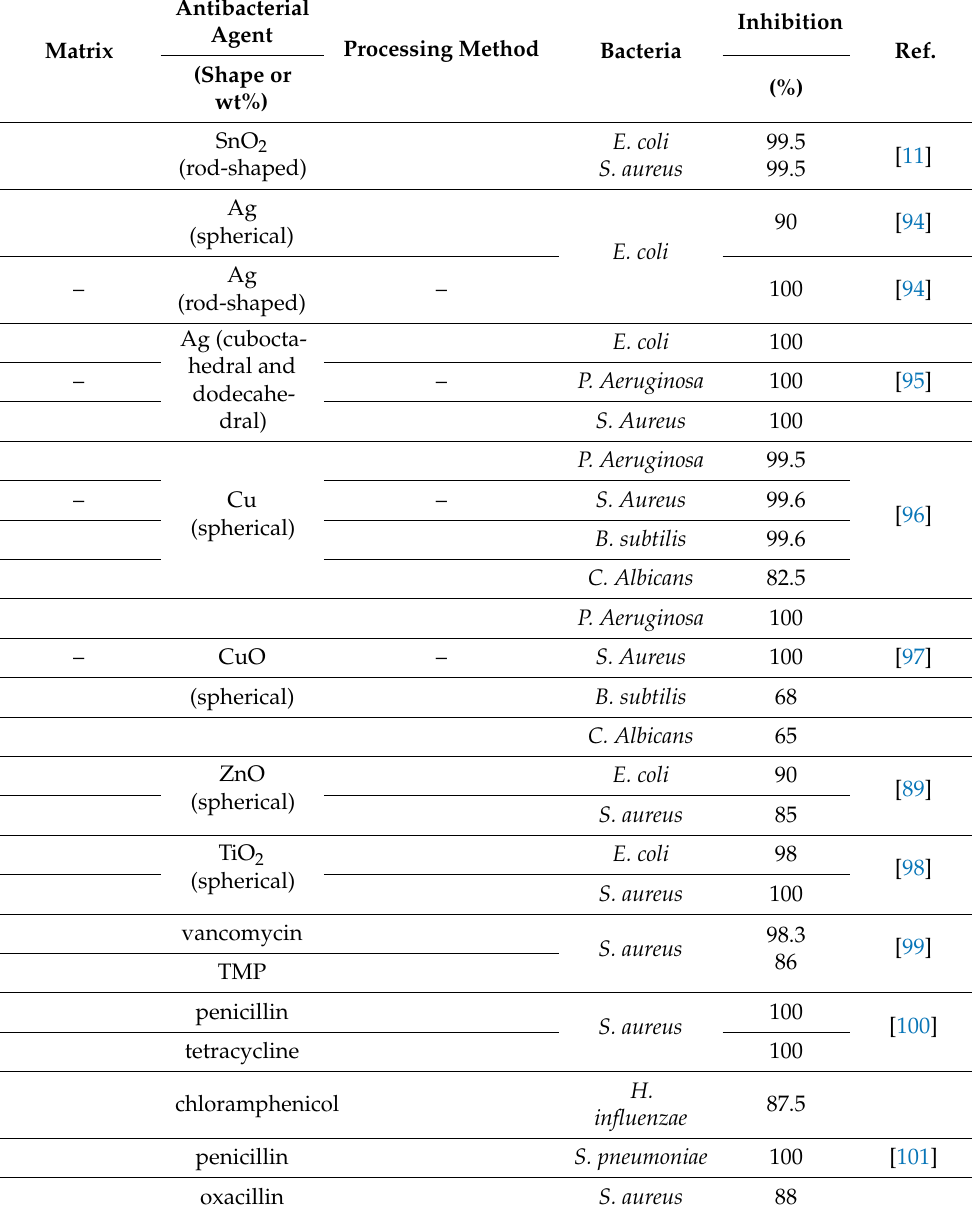
Table 1. Comparison between the antimicrobial activity of nanoparticles, antibiotics, and polymer nanocomposites with carbon-based